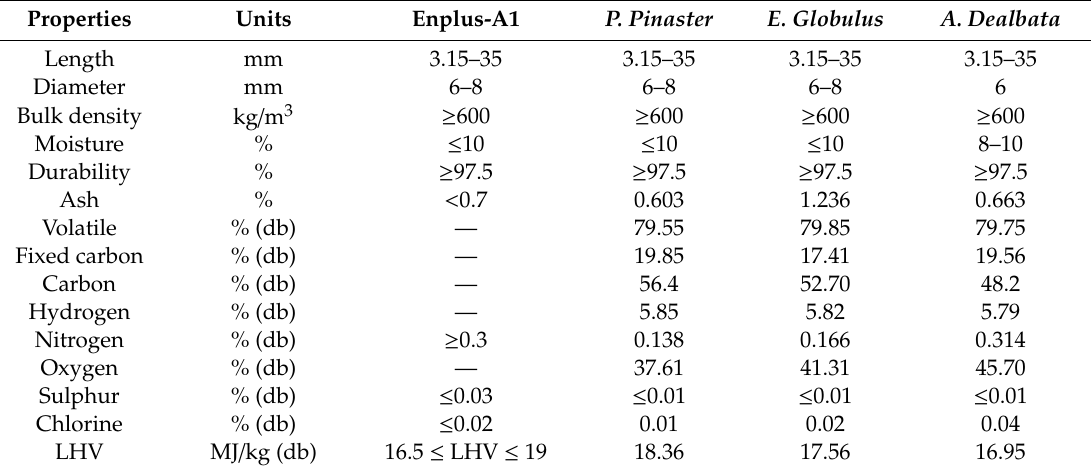
Figure 4. Combustion test of the pellets in an industrial thermal oil boiler. ( a ) The discharge of a pellet big bag into the boiler feed system; ( b ) the detail of the pellet discharge; ( c ) the boiler where the test was conducted; ( d ) the detail of the “eye” of the furnace in full combustion; and ( e ) the boiler control unit and the operating parameters. Table 3. Comparison between the properties of the A. dealbata biomass and the reference values presented in the ENPlus